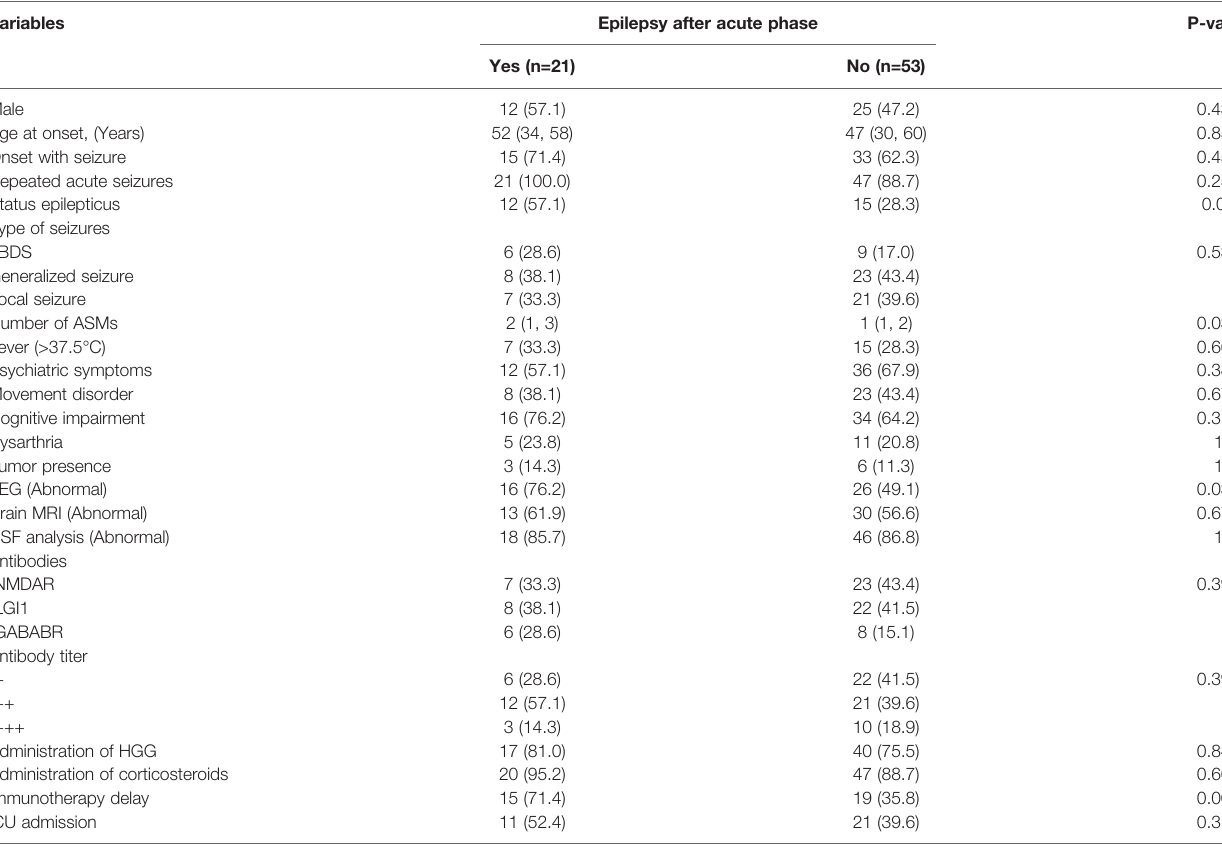
TABLE 5 | Univariate analysis of factors associated with the development of epilepsy in total AE patients. Variables Epilepsy after acute